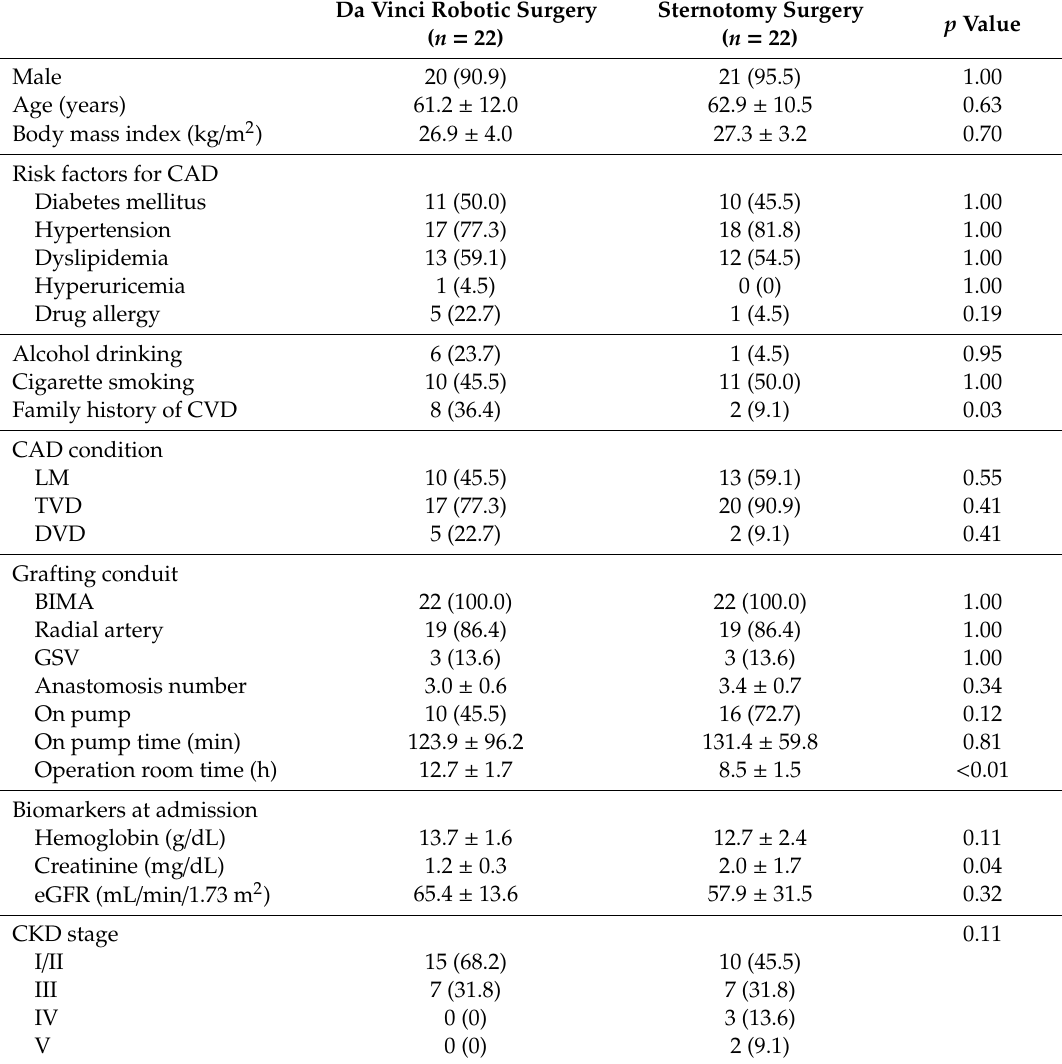
Table 1. Baseline characteristics between two surgical